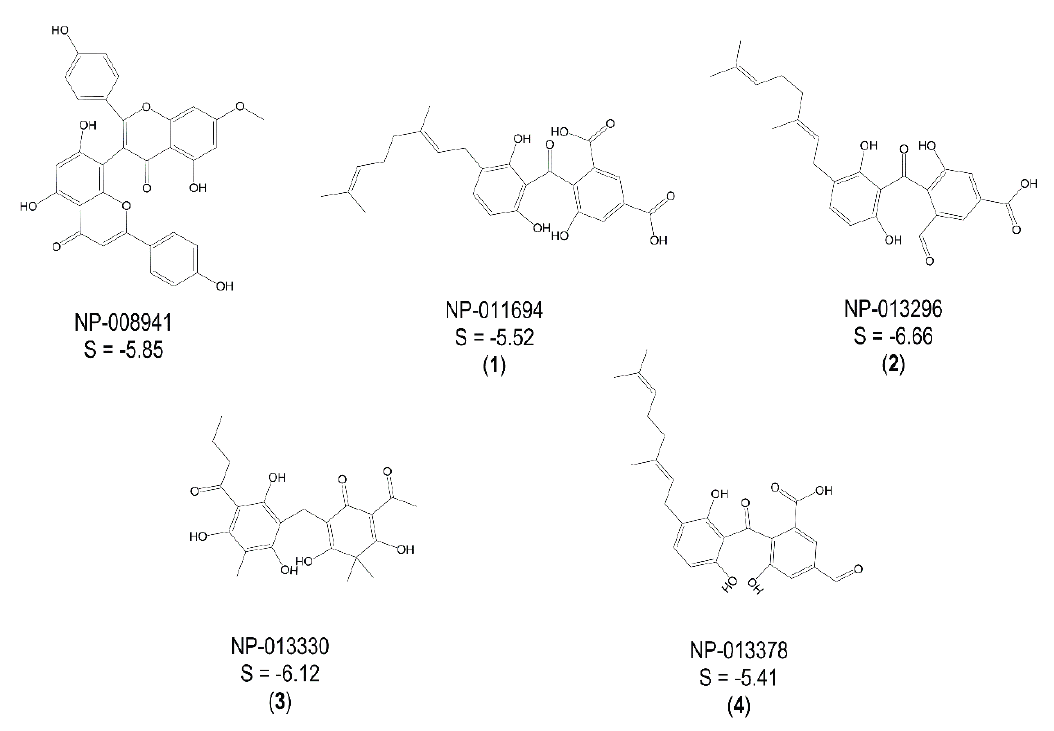
Figure 1. Best hits from the virtual screening based on the G-3-P pharmacophore;